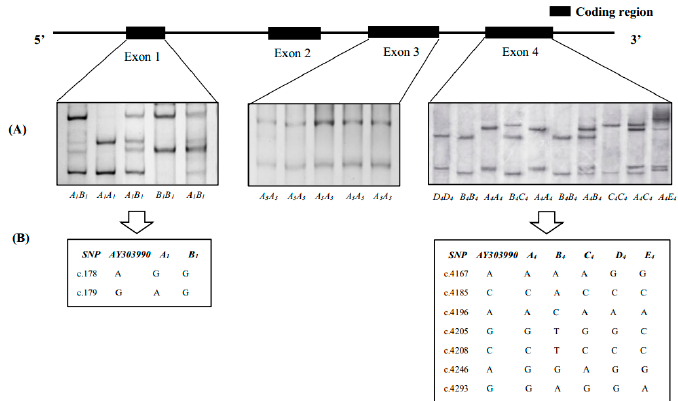
Figure 1. The SSCP analysis results and the single nucleotide variations identified in the SLA ‐ DRA gene of Yantai black pigs. Unique PCR ‐ SSCP results ( A ) representing different genotypes were detected in exon 1, 3 and 4. The coordinates of SNPs were annotated ( B ) based on the swine SLA ‐ DRA reference sequence (accession no: AY303990) in GenBank.